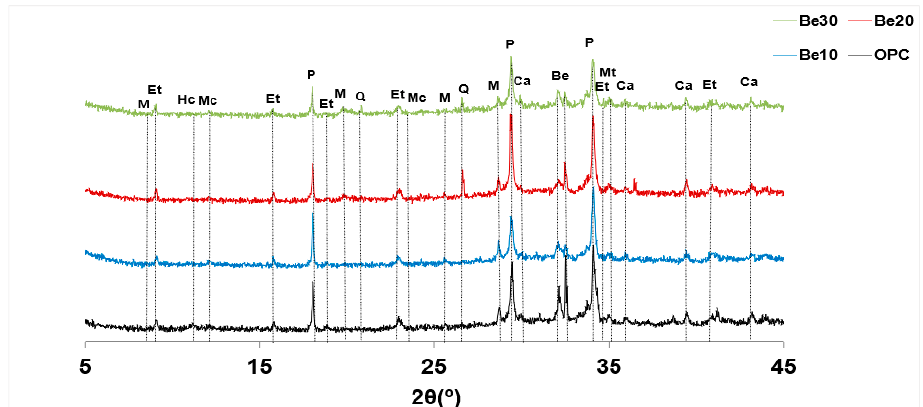
Figure 6. XRD patterns for unadditioned CEM I 52.5R–SR 3 and the same cement with 10%, 20% or 30% bentonite.